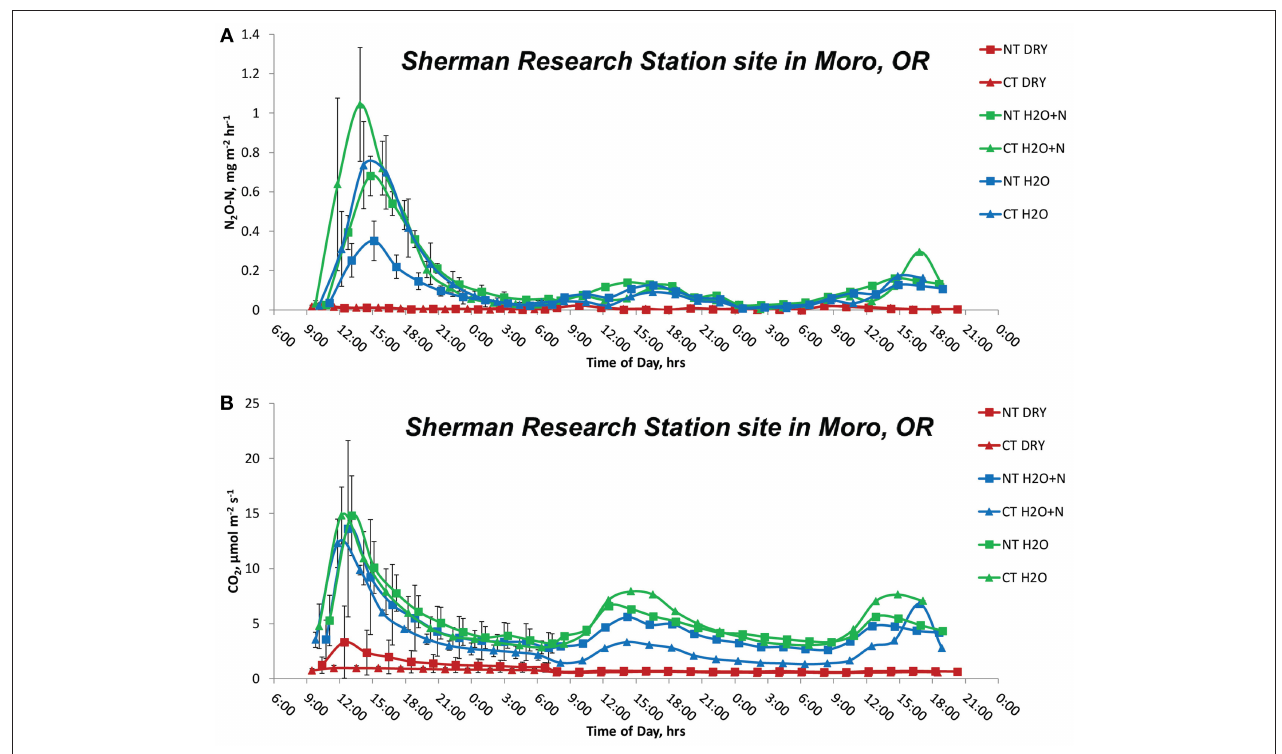
FIGURE 1 | Emissions of N 2 O (A) and CO 2 (B) during the first 3 days (0–72h) of measurements with and without additions of 150kg N ha − 1 and water to no-tillage and conventional tillage management systems at Moro, OR site.